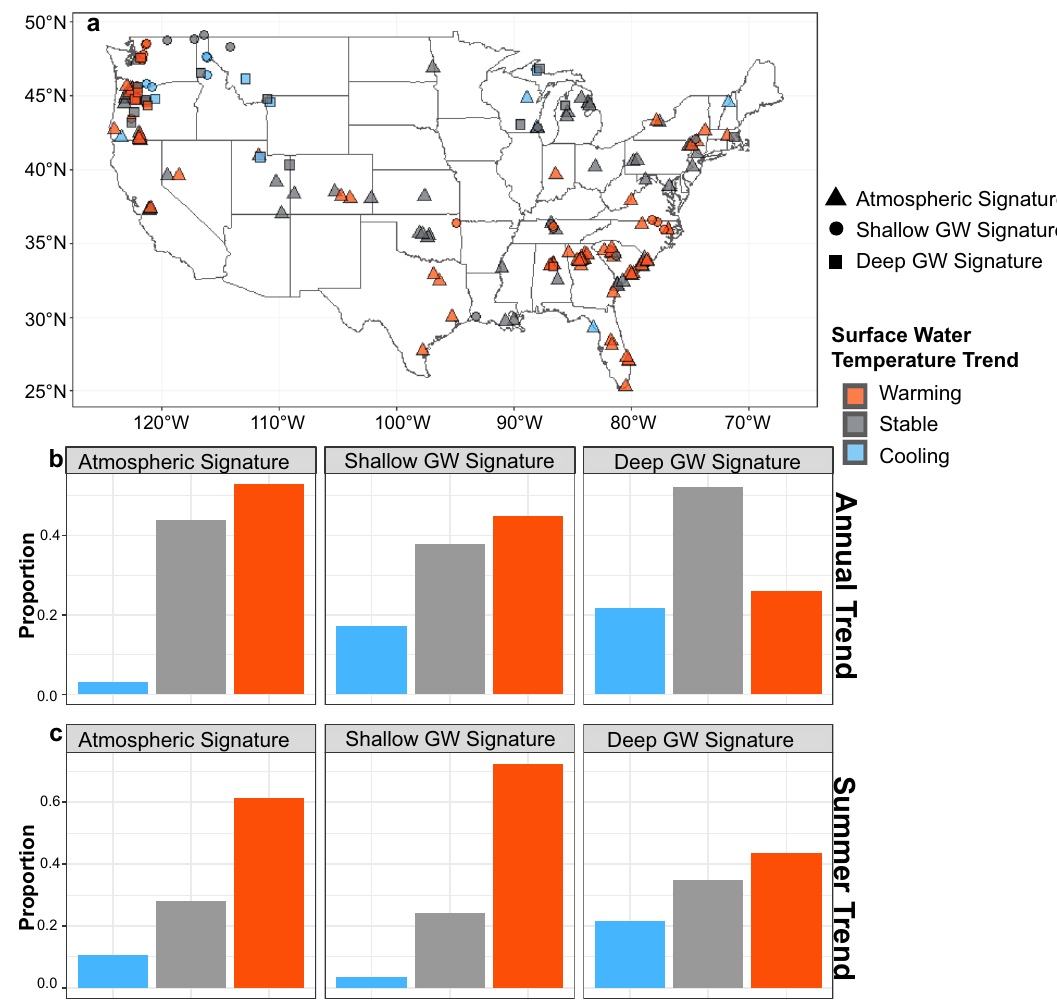
Fig. 4 Stream water temperature trends based on average monthly values for 14 – 30 years of data post 1990. a Spatial distribution of stream water temperature annual trends across the United States by groundwater (GW) signature category. Base map was generated from R package ‘ maps ’ version 3.3.0. b The proportion of sites with long-term annual temperature increasing (warming (red), p < 0.05), decreasing (cooling (blue), p < 0.05) monotonic trends, or stable condition (gray) ( p > 0.05) by GW signature category. c Similarly, the long-term temperature trends based on summer temperatures (June – August) by GW signature category. Site counts of each category in a – c are atmospheric signature (triangle) n = 132; shallow GW signature (circle) n = 29; and deep GW signature (square) n =